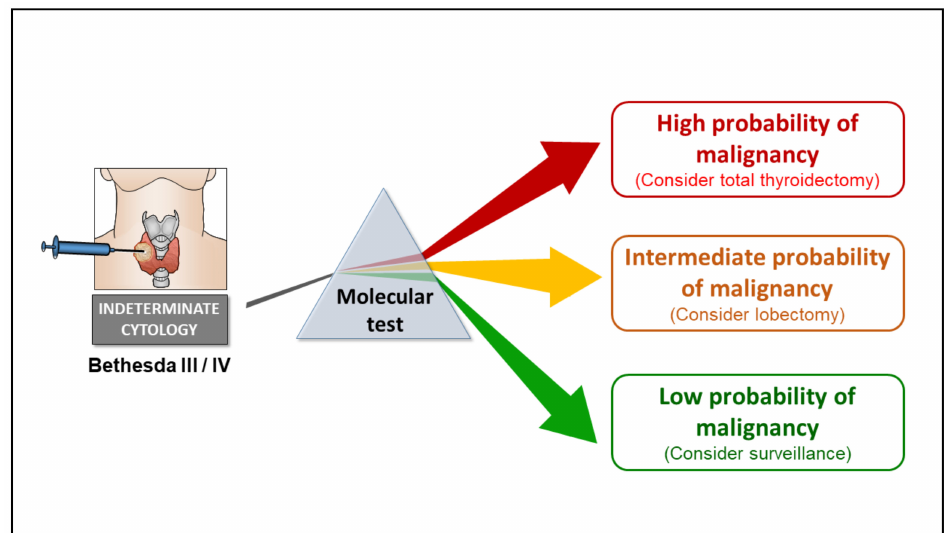
Figure 1. Model illustrating role of molecular testing for refining the cancer risk stratification of cytologically indeterminate (Bethesda III or IV) thyroid nodules. Current versions of molecular tests described in this review offer varying degrees of risk stratification, but for the most part, test results fall into one of three categories: low, intermediate, or high probability of cancer. A high negative predictive value (NPV) is a key feature shared by all the tests described herein. Among most cohorts of Bethesda III/IV nodules, a NPV greater than 95% (as demonstrated by clinical validation studies) indicates that the cancer risk associated with a negative molecular testing result is less than 5%, similar to that of a cytologically benign